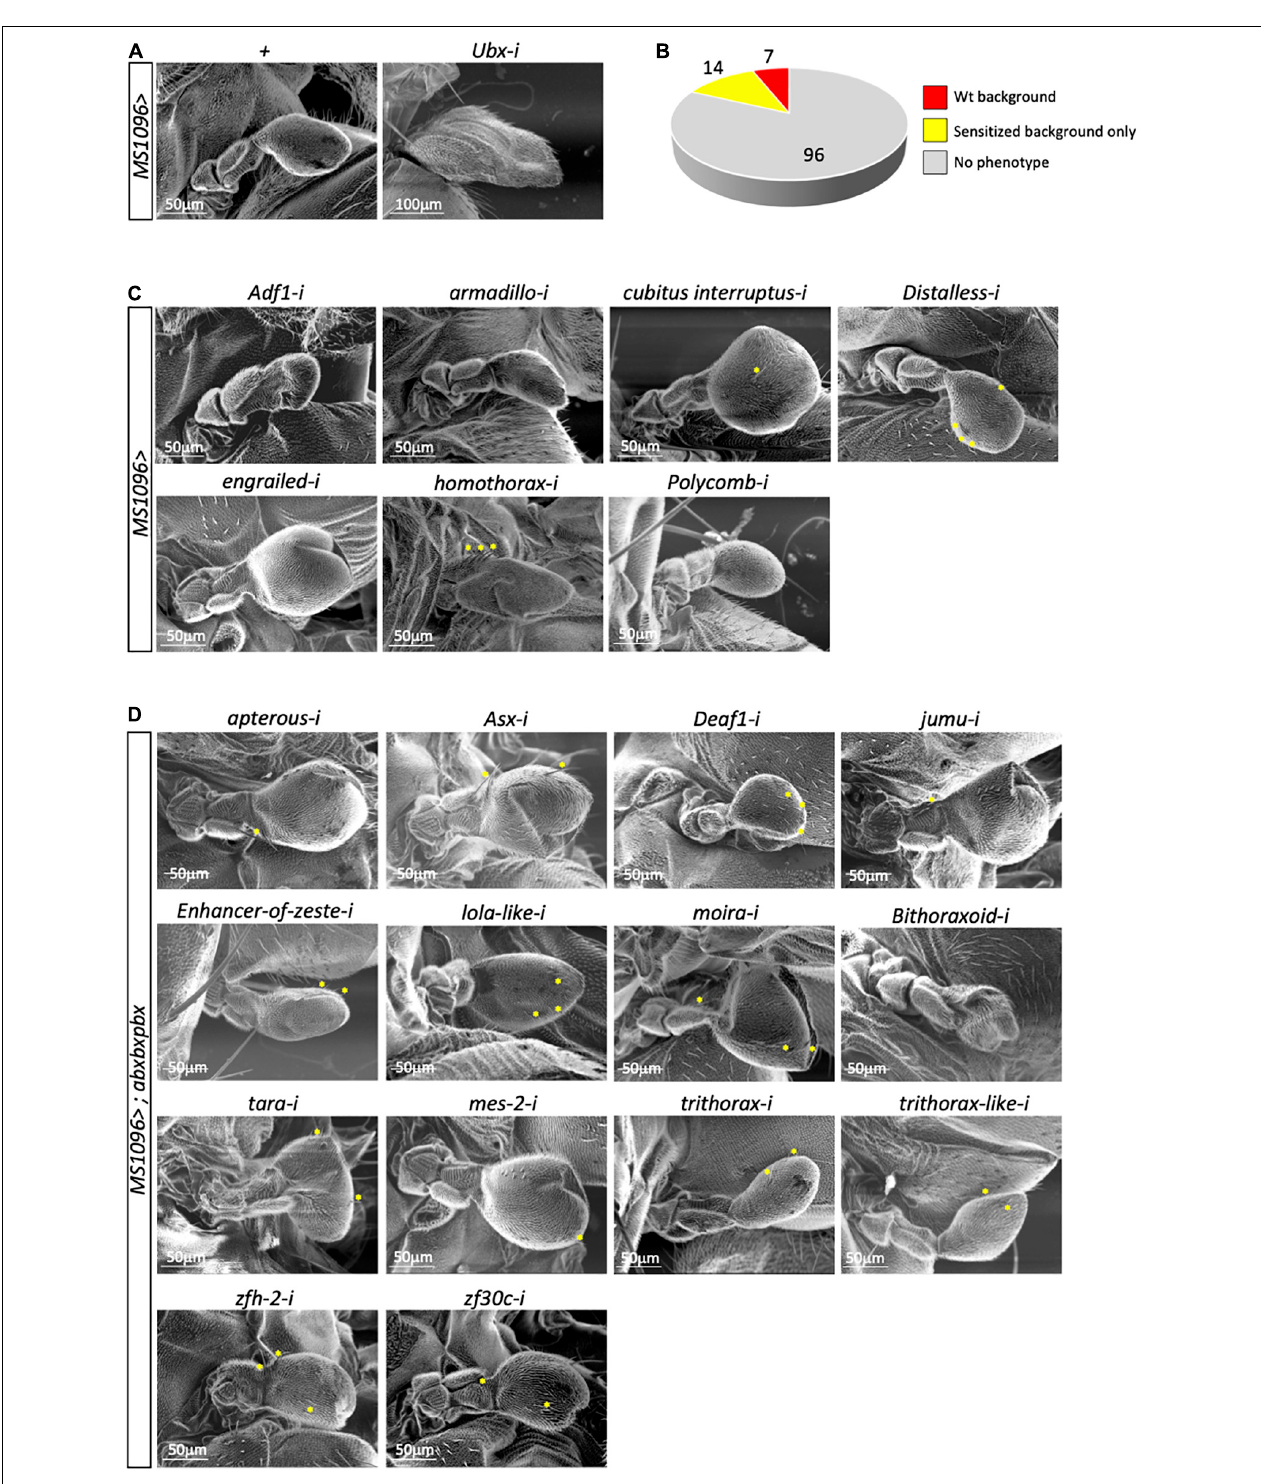
FIGURE 2 | A candidate RNAi screen for transcription factors revealed few potential Ubx cofactors in the haltere disc. (A) Control haltere phenotypes in the MS1096/ + or MS1096/ + ; UAS-UbxRNAi/ + backgrounds, as indicated. (B) Summary of the number of genes leading or not to a phenotype (size and/or ectopic wing-like bristles) in the wild type ( wt , corresponding to MS1096/ +) or sensitized ( abxbxpbx/ +) contexts. (C) Illustrative SEM pictures of phenotypes obtained with the different targeted genes in the wild type context, as indicated. (D) Illustrative SEM pictures of phenotypes obtained with the different targeted genes in the sensitized context, as indicated. Ectopic wing-like bristles are indicated when present (yellow stars). See also Supplementary Tables 1 – 3 .